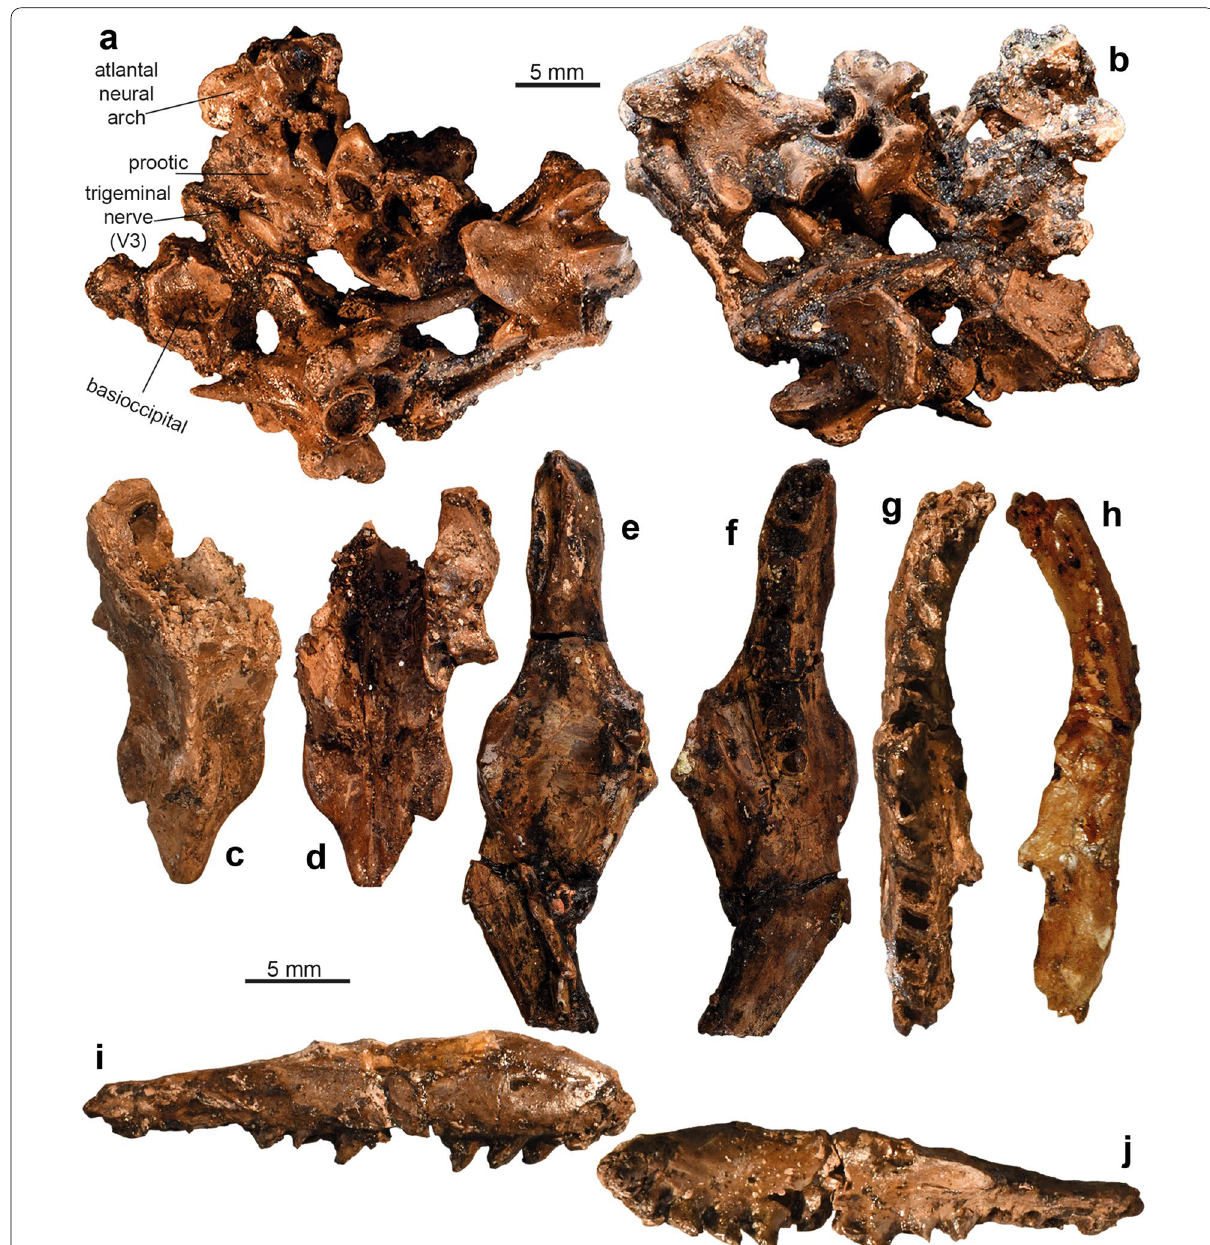
Fig. 68 Eoconstrictor spinifer comb. nov. from quarry Cecilie I, Geiseltal—all parts of the lectotype (herein designated): a , b “block” including the left atlantal neural arch, three almost complete anterior trunk vertebrae, remains of ribs, fragments of other vertebrae, as well as basioccipital, and right prootic (GMH Ce I-2979-1926) in dorsal ( a ) and ventral ( b ) views; c , d parietal (GMH Ce I-5823-1926) in dorsal ( c ) and ventral ( d ) views; e , f right pterygoid (GMH Ce I-5824-1926) in dorsal ( e ) and ventral ( f ) views; g – j right maxilla (GMH Ce I-5826-1926) in ventral ( h ), dorsal ( i ), labial ( j ), and medial ( k ) views. The second scale bar applies to all images